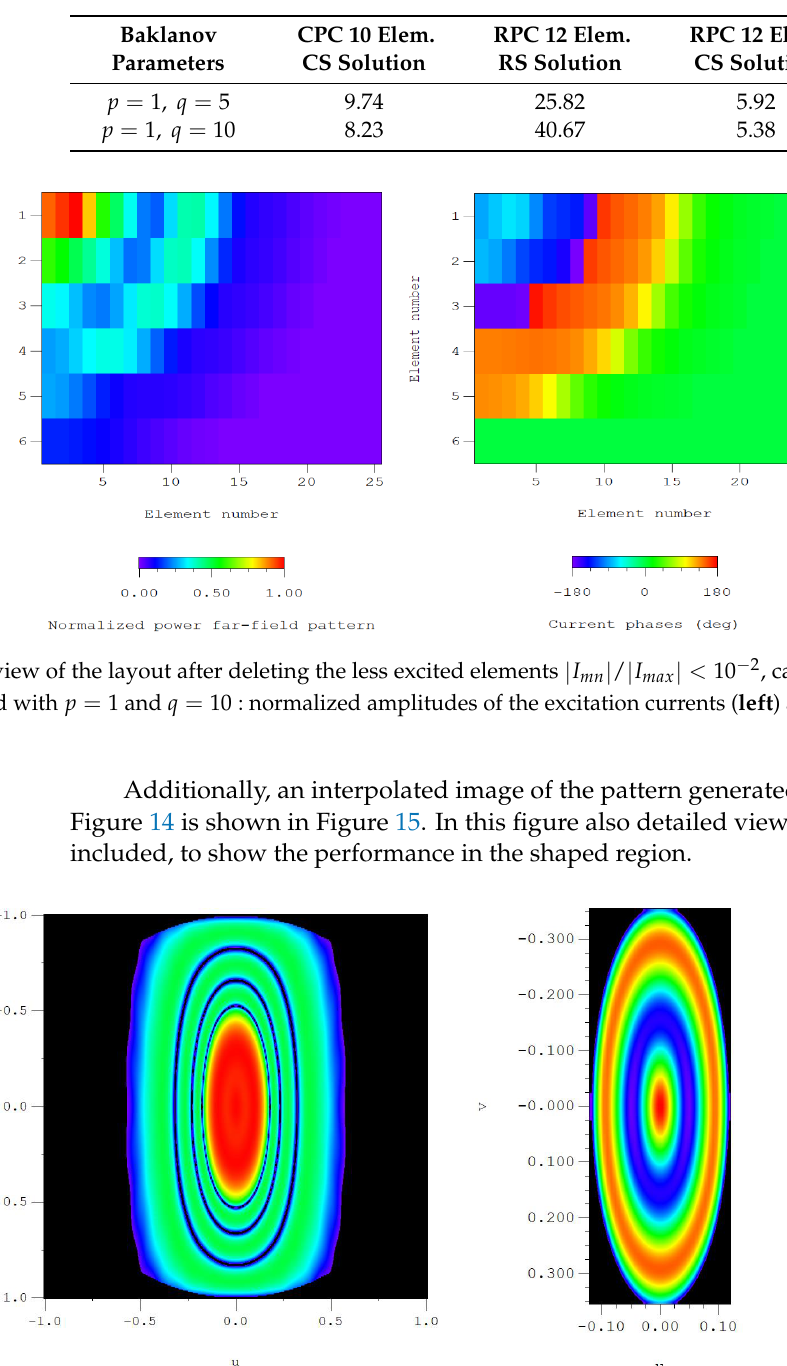
Table 10. Dynamic range ratio ( | I max | / | I min | ) of the current excitation amplitudes of the planar array generated by means of the generalisation of Tseng and Cheng method. Element currents with